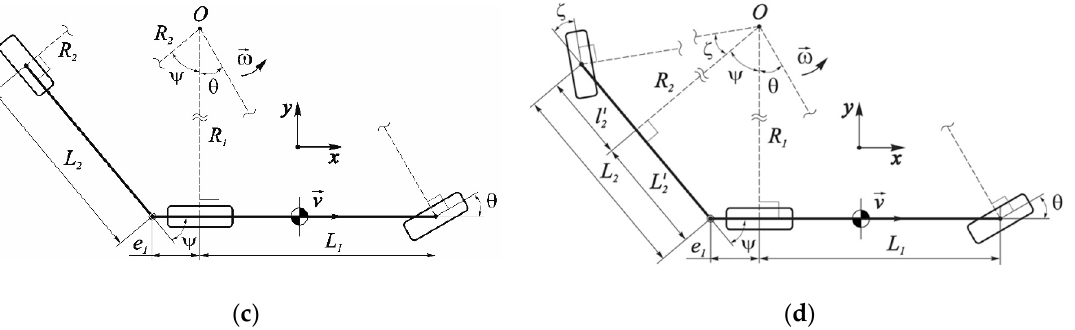
Figure 1. Kinematics of curvilinear motion for di ff erent types of vehicle design: ( a ) Passenger car; ( b ) Single truck with steered rear axle; ( c ) Conventional tractor-semitrailer vehicle (TSV); ( d ) Tractor- semitrailer vehicle with semitrailer’s steered axles